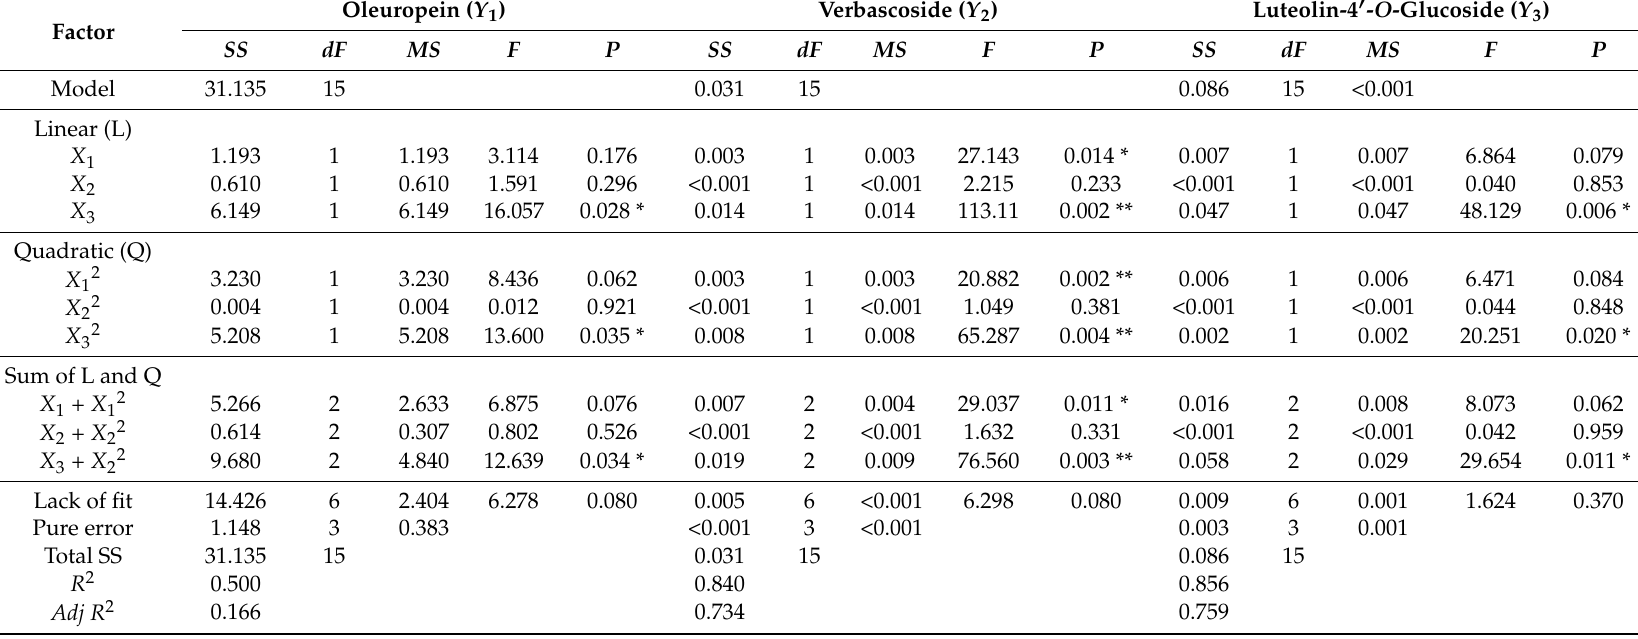
Table 2. ANOVA for response surface models (RSM) for all independent variables (model: no interactions, real values of independent variables).